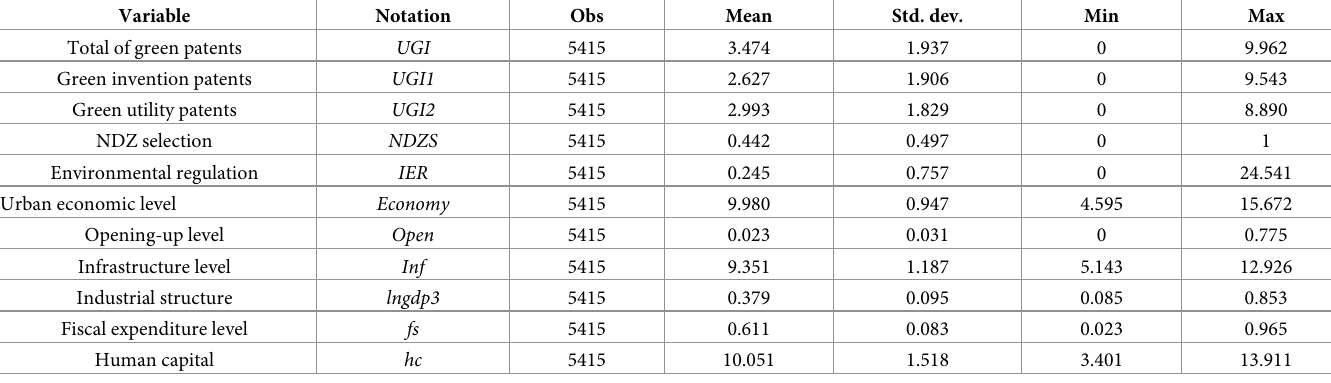
Table 1. Summary